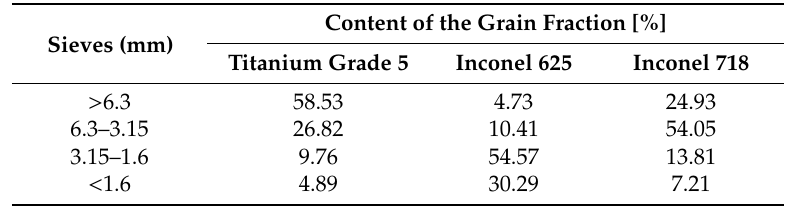
Table 1. Granulometric composition of alloy swarfs: Titanium Grade 5, Inconel 625, Inconel 718 in percentage after previous removal of organic parts from the surface.